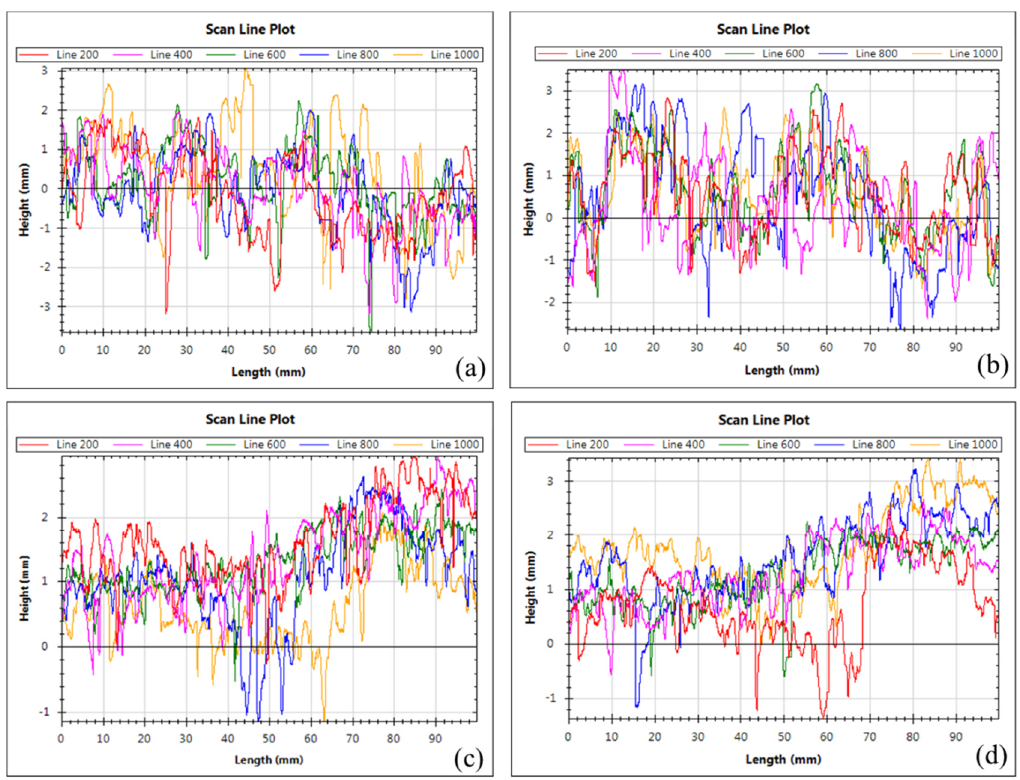
Figure 9. Scan line plots of ( a ) Type II, ( b ) MS-basalt, ( c ) MS-limestone, and ( d ) MS-steel slag.